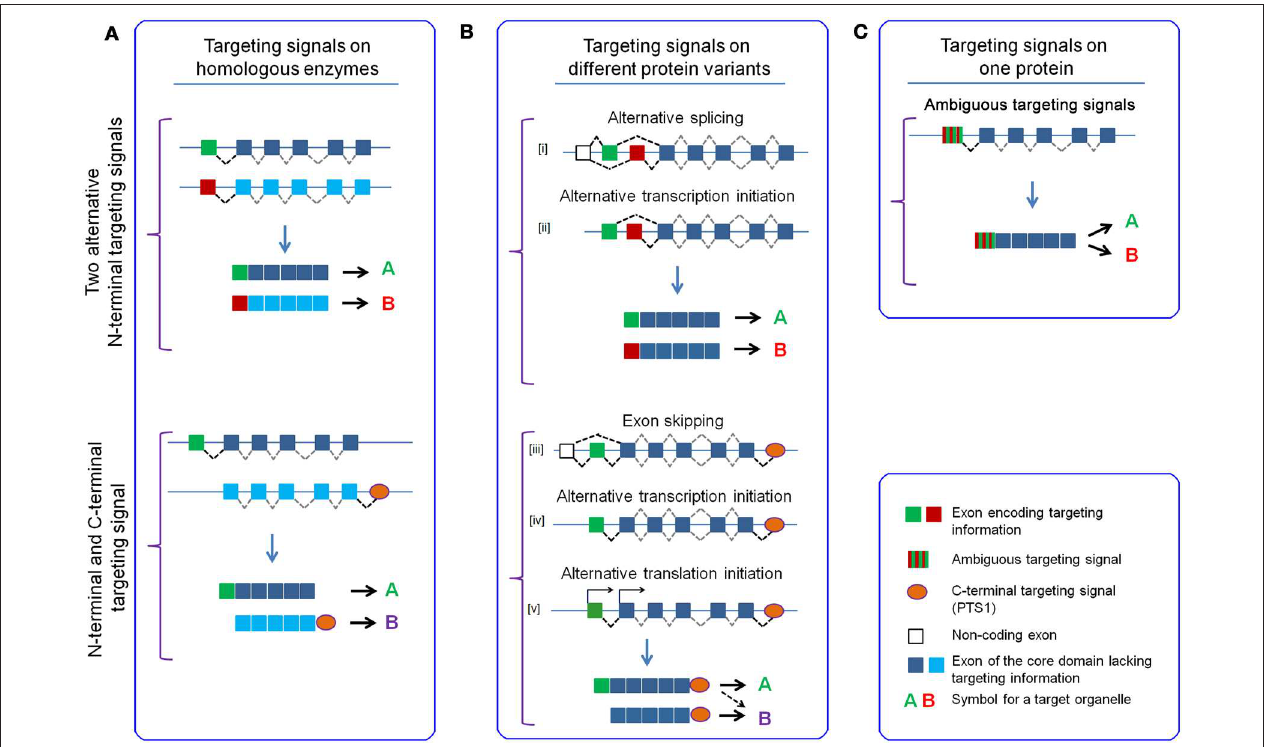
FIGURE 4 | Mechanisms to provide the same enzymatic activity or protein function within different subcellular compartments. Bilocalization of protein(s) requires the presence of two alternative targeting signals, which can be either encoded by alternative N-terminal sequences ( upper part ) or can be encoded by an N-terminal targeting signal and a C-terminal PTS1, respectively ( lower part ). (A) Two independent genes code for proteins with the same enzymatic activity of function (isoenzymes/homologoues), which harbor different targeting signals. (B) Two variants of the same protein are generated from a single gene, which share the core domain(s), but differ in the encoded targeting signals; variants encoding alternative N-terminal sequences can be obtained by [i] alternative splicing from the same pre-mRNA with a non-coding first exon or [ii] by alternative transcription initiation generating alternative first exons, which use to the same splice acceptor site of the second exon. Variants with and without N-terminal targeting signal, but sharing a C-terminal PTS1 can be generated by [iii] exon skipping behind the first non-coding exon, which omits the second exon encoding the N-terminal targeting signal, [iv] alternative transcription initiation ablating the first exon and [v] alternative translation initiation at different start codons within the same mRNA. (C) One protein is equipped with an ambiguous targeting signal, which is sufficient to mediate the concomitant targeting of the protein to more than one